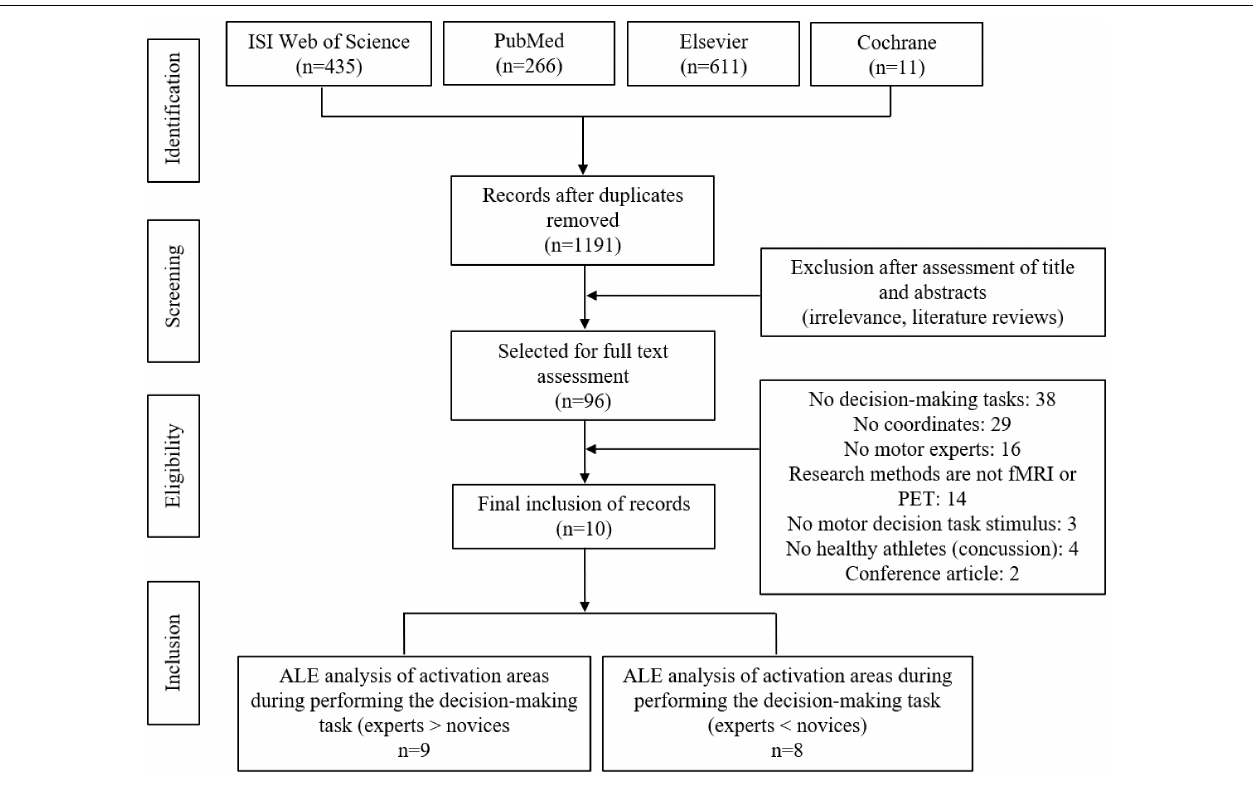
FIGURE 1 | Flowchart describing the process of study selection. TABLE 1 | Basic information included